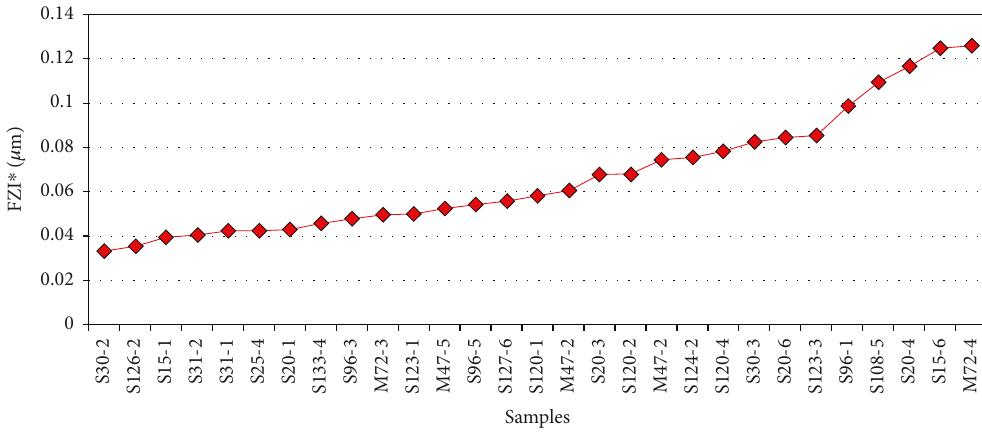
Figure 17: The FZI ∗ of